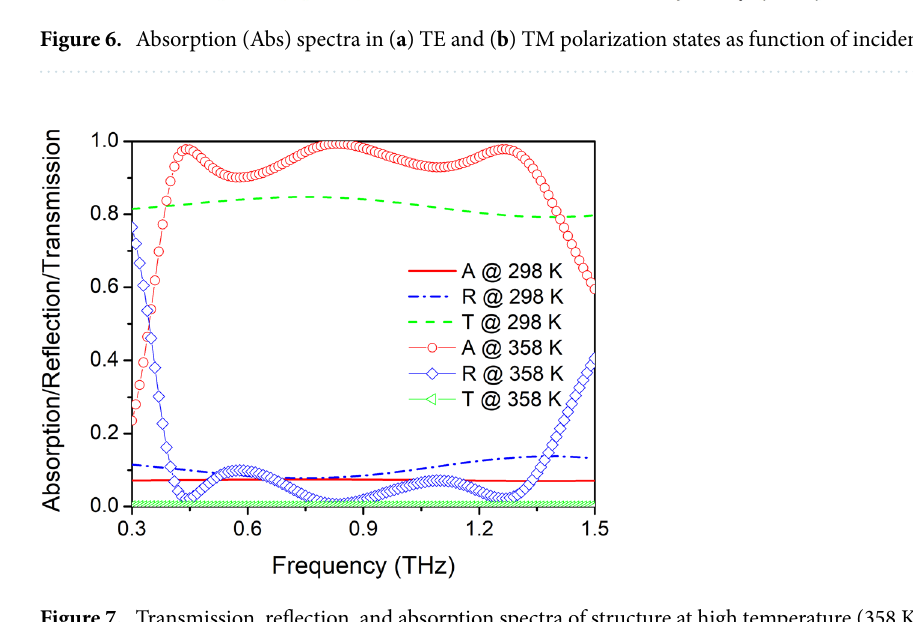
Figure 7. Transmission, reflection, and absorption spectra of structure at high temperature (358 K, VO 2 conductivity of 200,000 S/m) and at room temperature (VO 2 conductivity of 200 S/m). Red line (A) represents the absorption rate, blue line (R) represents the reflectivity, and green line (T) stand for the